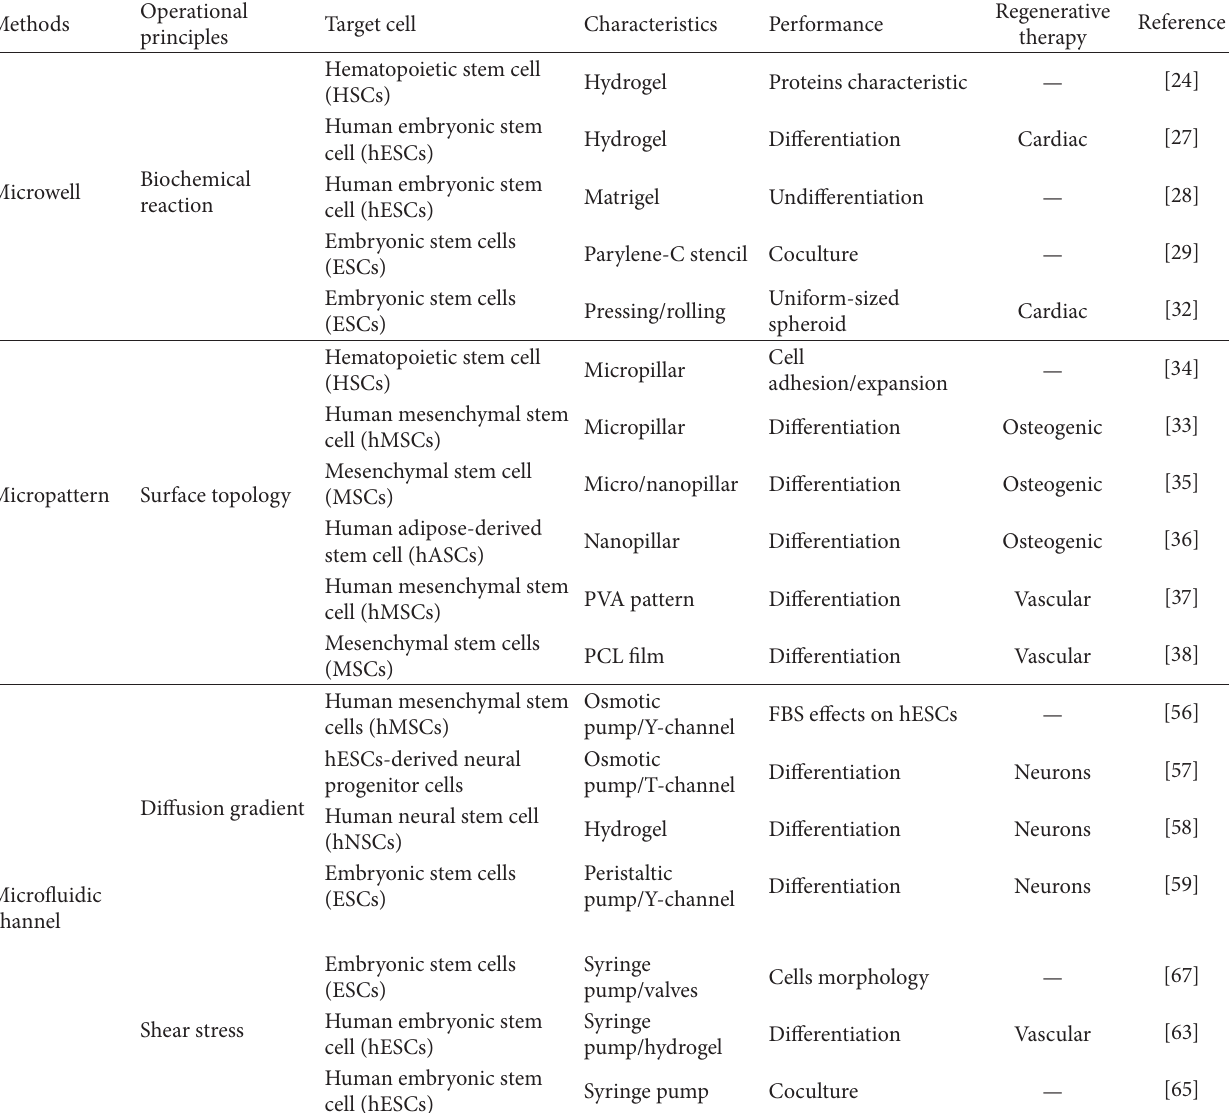
Table 1: Summarization of the cell operational principles, target cells, characteristics, performance, and regenerative